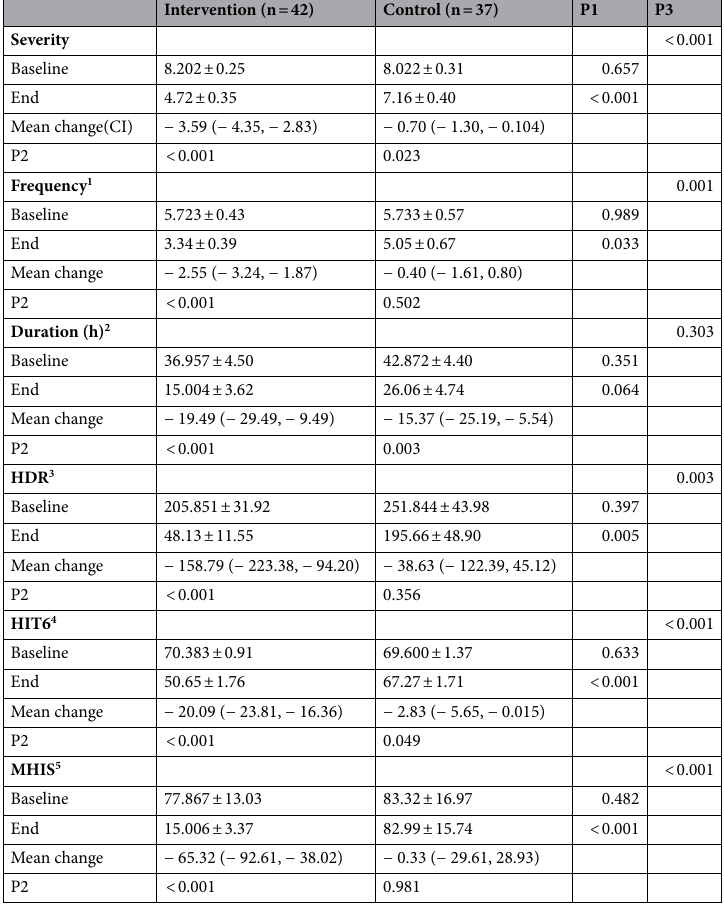
Table 3. The effects of Alpha-lipoic acid supplementation on migraine symptoms. P1 resulted from independent t-test, P2 resulted from paired sample t-test, P3 resulted from analysis of covariance in the adjusted models (adjusted for baseline level of each Variable, age, BMI, Marital status, Education status, Economic status, Gabapentin from drugs, Physical activity and energy intake); All values are means ± SE. 1 Frequency of attacks per month. 2 Average duration of migraine attack (hr). 3 Headache dairy results: Duration of headache (hr) × frequency of headache. 4 Headache Impact Test-6. 5 Migraine Headache Index Score: Duration of headache (day) × frequency of headache ×